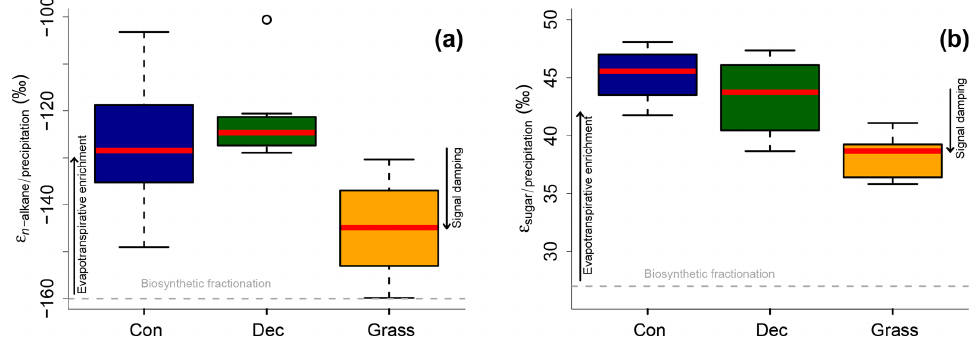
Figure 7. Apparent fractionation (a) ε n -alkane/precipitation and (b) ε sugar / precipitation . Biosynthetic fractionation factors according to Sect. 2.4.2. Box plots show the median (red line), interquartile range (IQR) with the upper (75%) and lower (25%) quartiles, lowest whisker still within 1.5 IQR of the lower quartile, and highest whisker still within 1.5 IQR of the upper quartile; dots mark outliers. Abbreviations: con: coniferous forest sites ( n = 9); dec: deciduous forest sites ( n = 11 and 14 for n -alkanes and sugars, respectively); grass: grassland sites ( n = 4 and 6 for n -alkanes and sugars, respectively). The figure conceptually illustrates the effect of biosynthetic fractionation and evapotranspirative enrichment as well as signal damping.